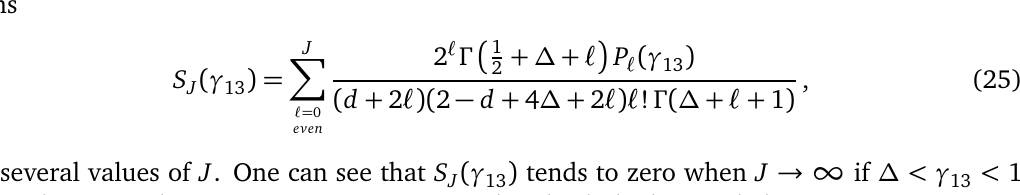
Figure 4: Partial sum S can see that only for ∆ < γ On the right, we fix γ predicted by (26). The straight orange line is a fit (to the points 20 ≤ J ≤ 60) with slope given by